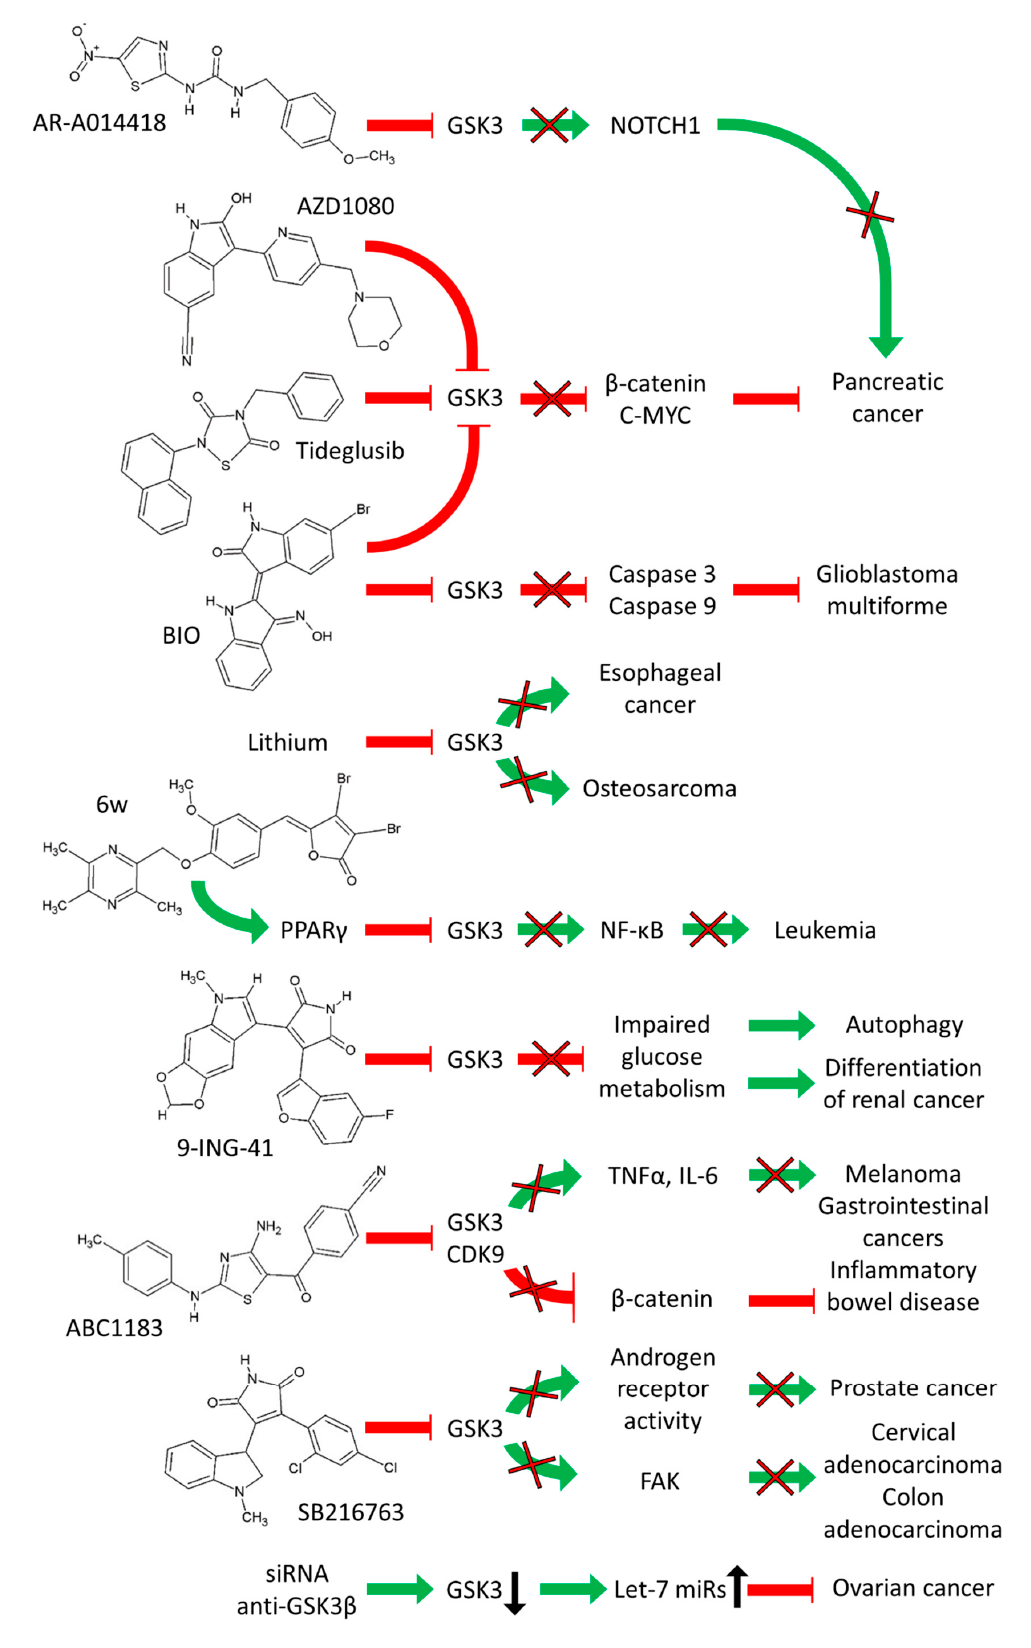
Figure 3. E ff ects of GSK-3 Inhibitors on Various Cancers. Green arrows indicate stimulation, blocked red arrows indicate